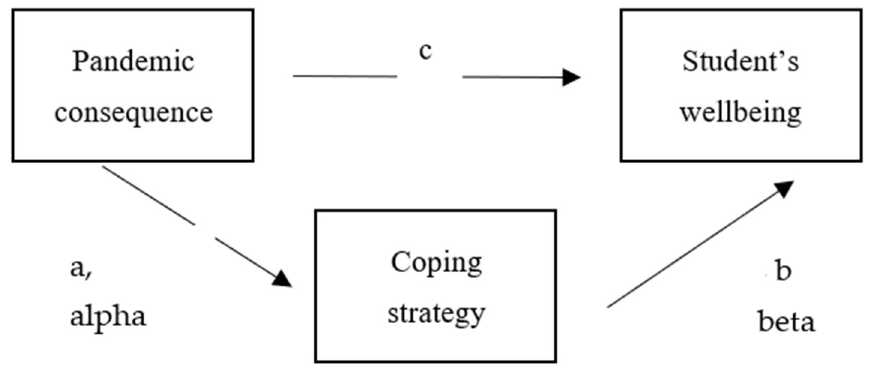
Figure 3. Mediation analysis of coping strategy on students’ wellbeing.